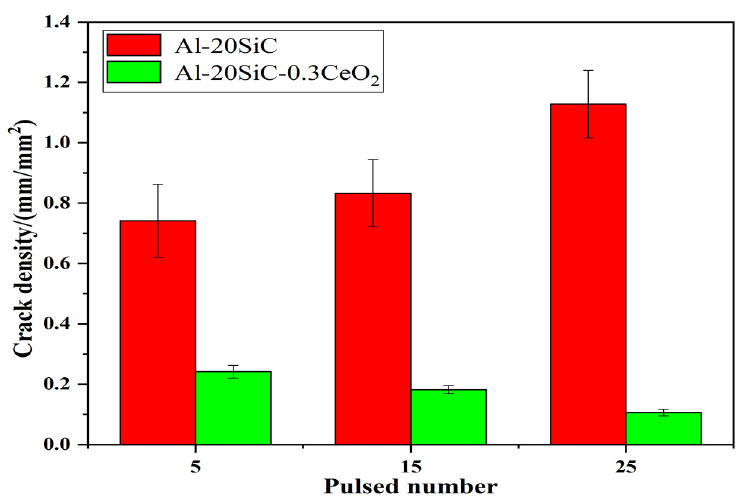
Figure 4. Crack density (crack length per unit area) against the pulsed number on the HCPEB- treated alloy surfaces. alloy